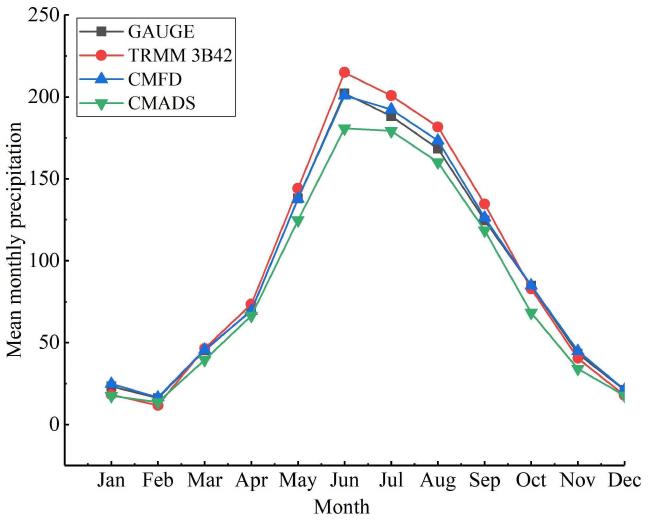
Figure 5. Comparison of the measured and monthly average precipitation results for each precipita- tion product in the study